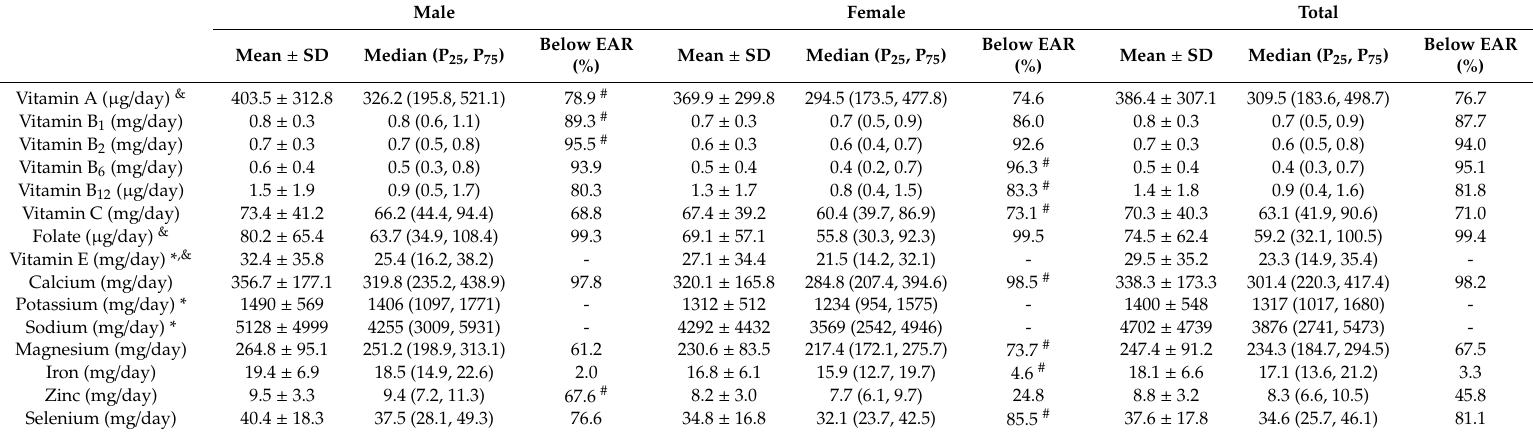
Table 2. Usual dietary intake and the prevalence of inadequacy of micronutrients in the subjects aged 60 years and over between genders. Male Female Total Below EAR Below EAR Below EAR Mean ± SD Median (P 25 , P 75 ) Mean ± SD Median (P 25 , P 75 ) Mean ± SD Median (P 25 , P 75 ) (%) (%) (%) Vitamin A ( µ g / day) & 403.5 ±